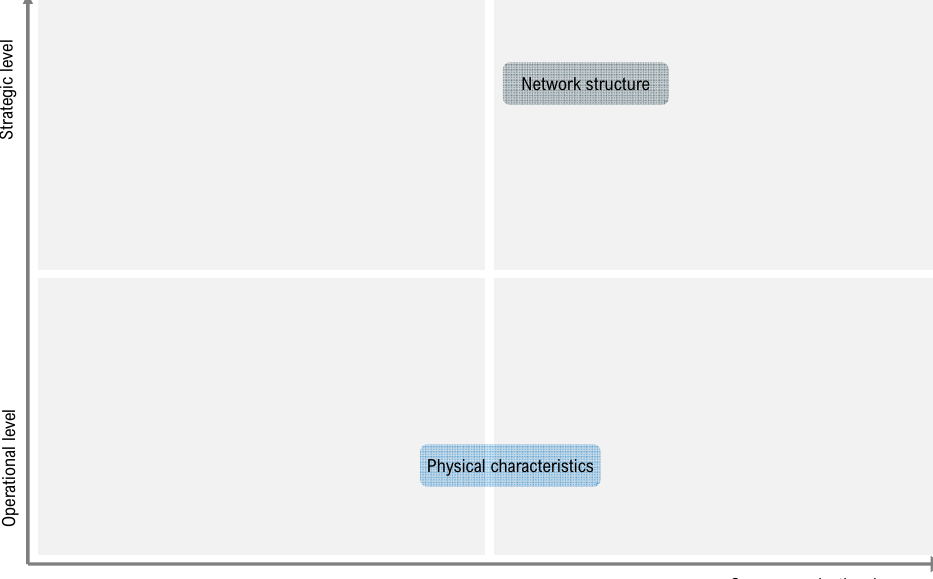
Figure 18. Suggested fields of action for the expert profile.